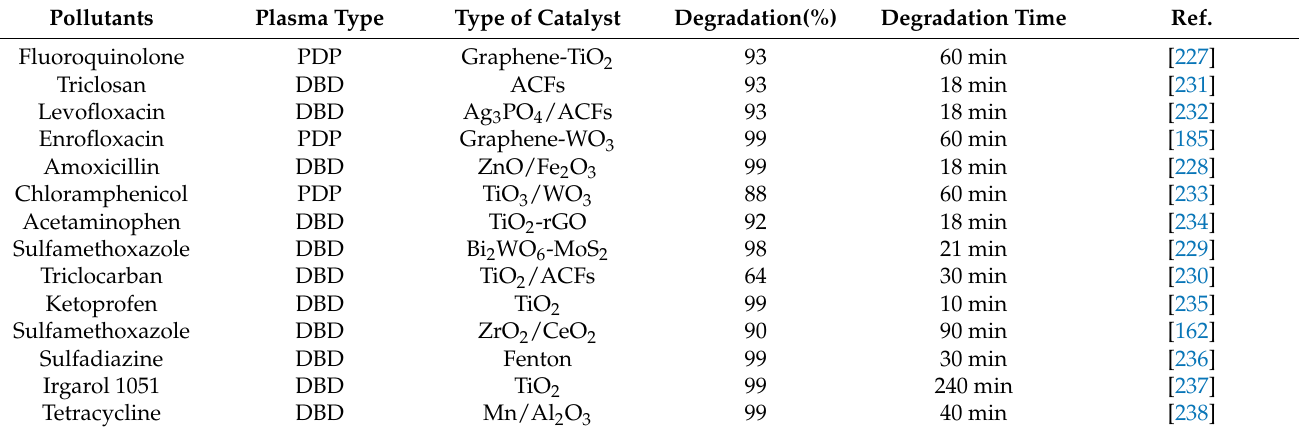
Figure 12. Proposed synthetic catalytic mechanism for pharmaceutical compound degradation in the NTP + graphene/TiO 2 system. Reprinted with permission from Ref. [227]. Copyright 2019, Elsevier. Table 6. Summary of the main operating conditions and catalysts used for the degradation of pharmaceutical compounds in aqueous phase by NTP coupled with catalysts.